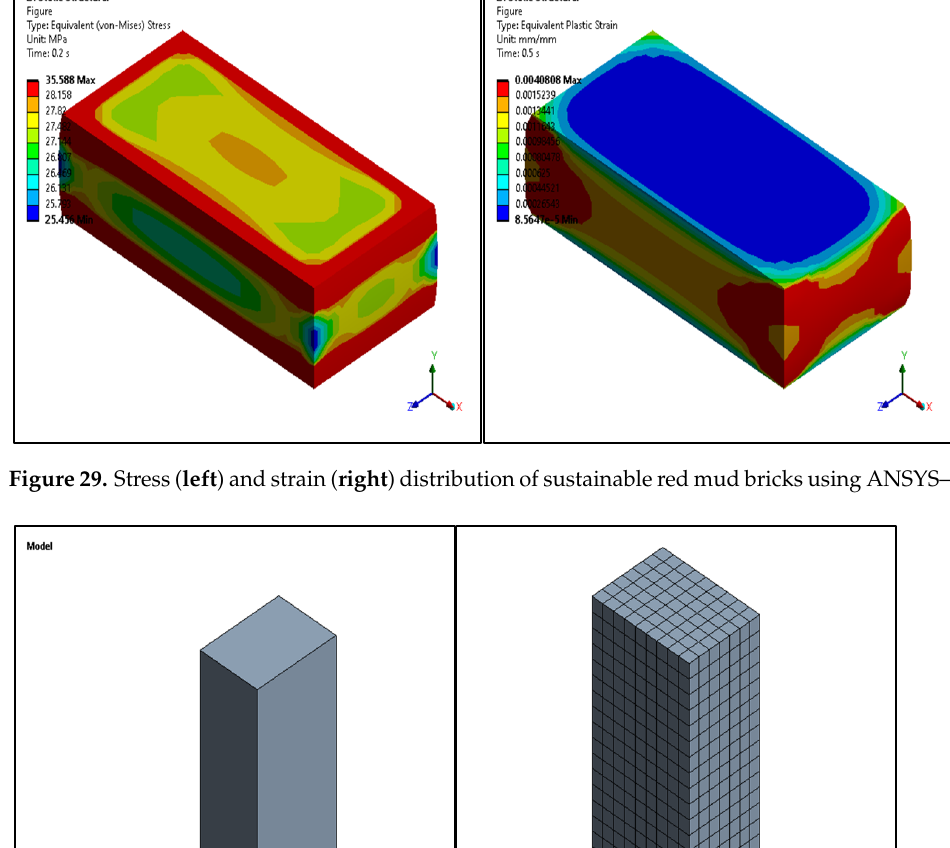
Figure 28. Total deformation of sustainable red mud bricks using ANSYS–HA.